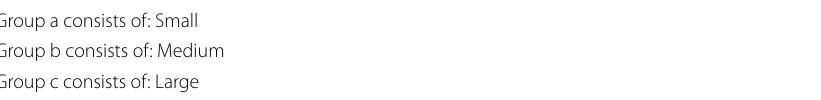
Table 18 HSD test groupings after ANOVA of AUPRC for the size